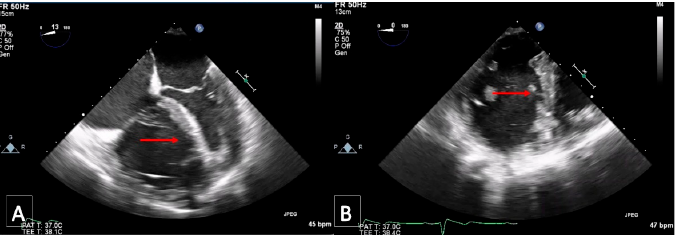
Figure 6. ( A ) Axial CT image with a central thrombus in the right pulmonary artery (red arrow); ( B ) right lung showing mosaic pattern whereas lucent areas correspond to perfusion defect (right upper lobe, red arrow).